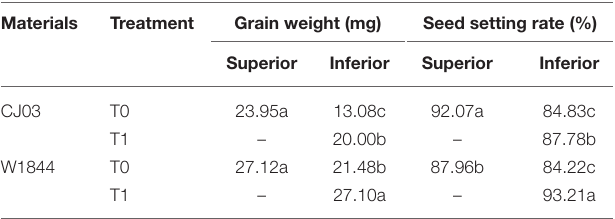
TABLE 2 | Grain weight and seed setting rate of CJ03 and W1844 under different treatments at